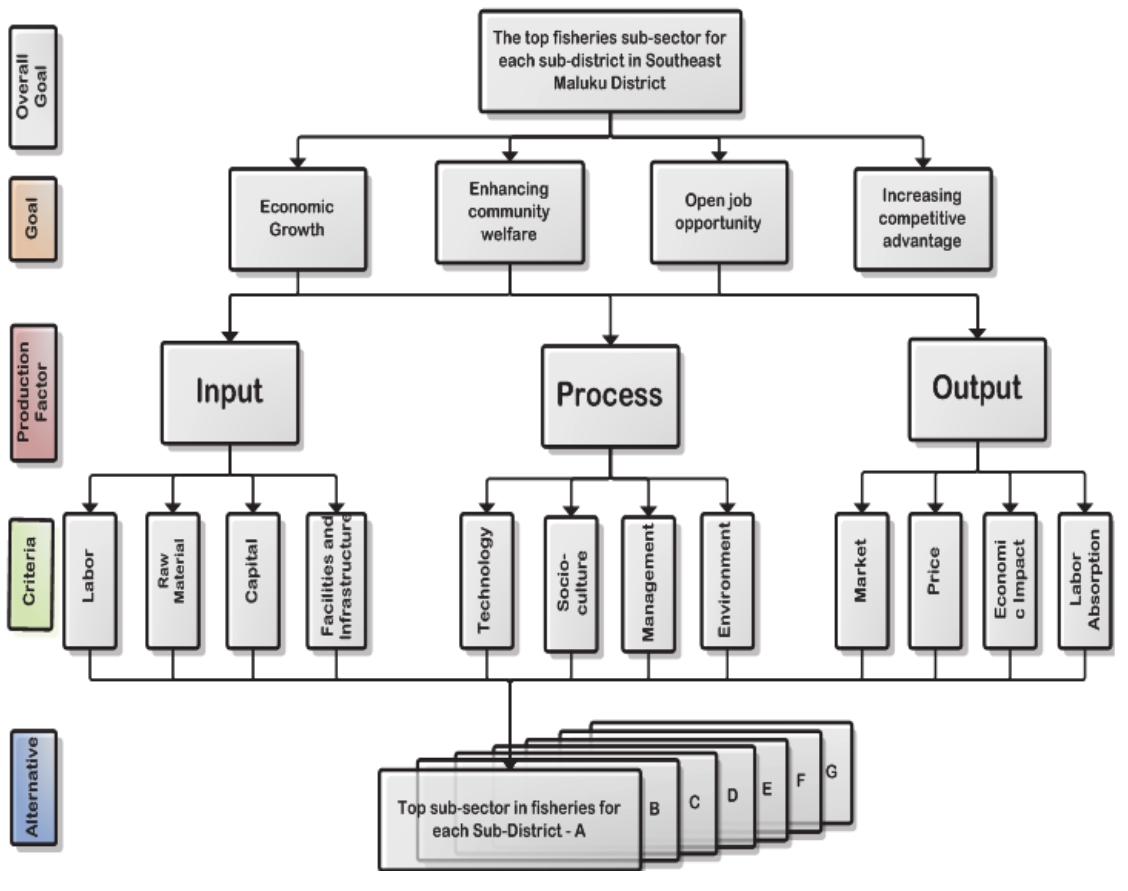
Fig. 3. Hierarchical structure of decision